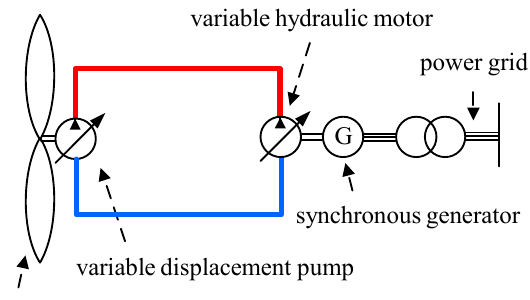
Figure 1. A schematic diagram of the hydraulic wind turbine.